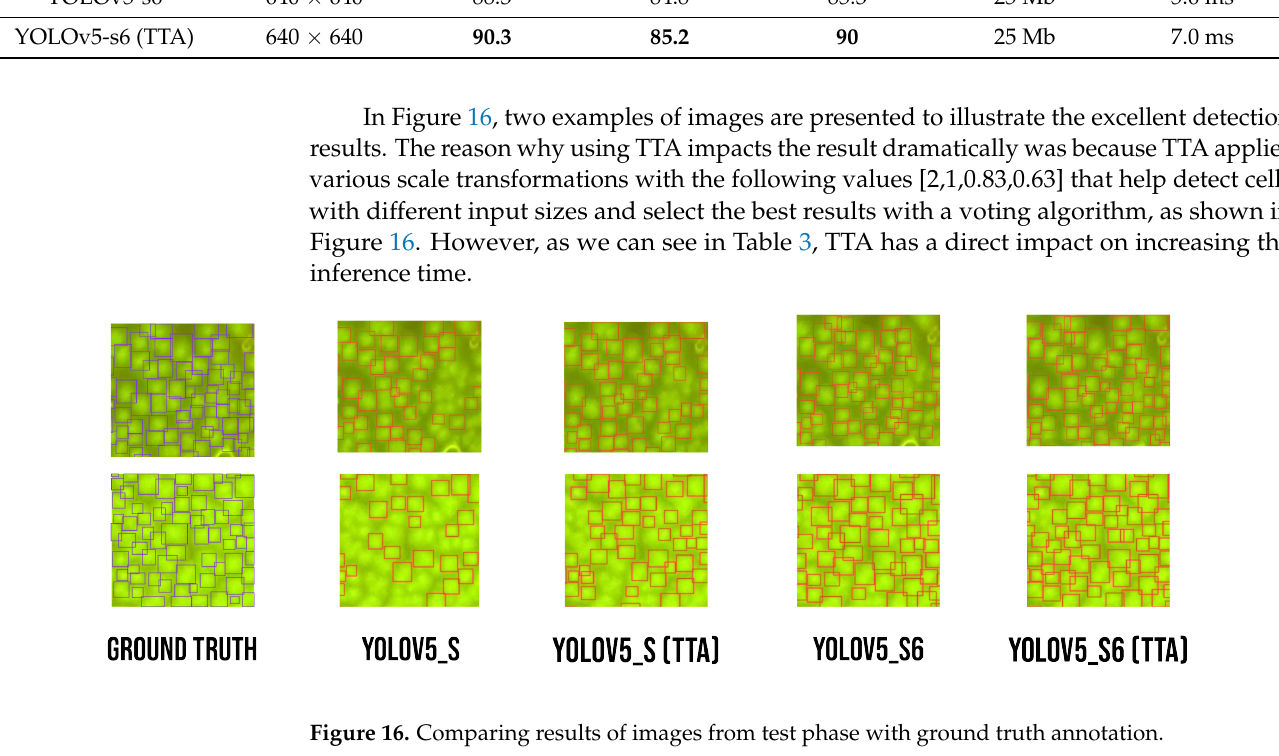
Figure 16. Comparing results of images from test phase with ground truth